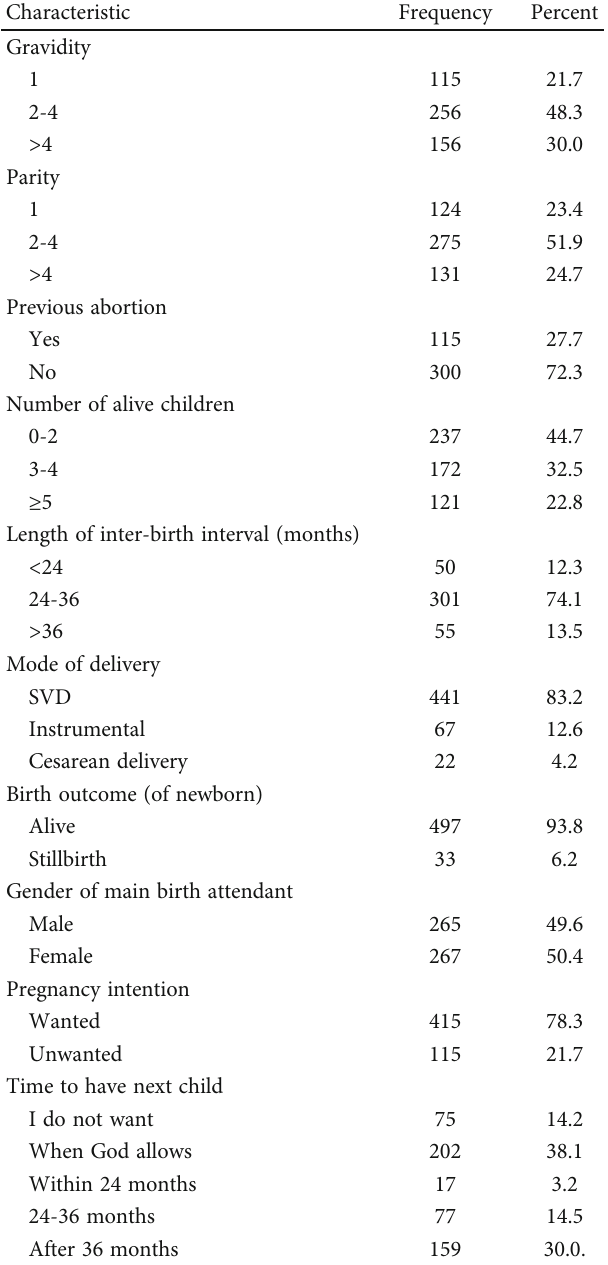
Table 2: Reproductive characteristics of women give birth in public health facilities in East Hararghe Zone, eastern Ethiopia, 2020 ( n = 530